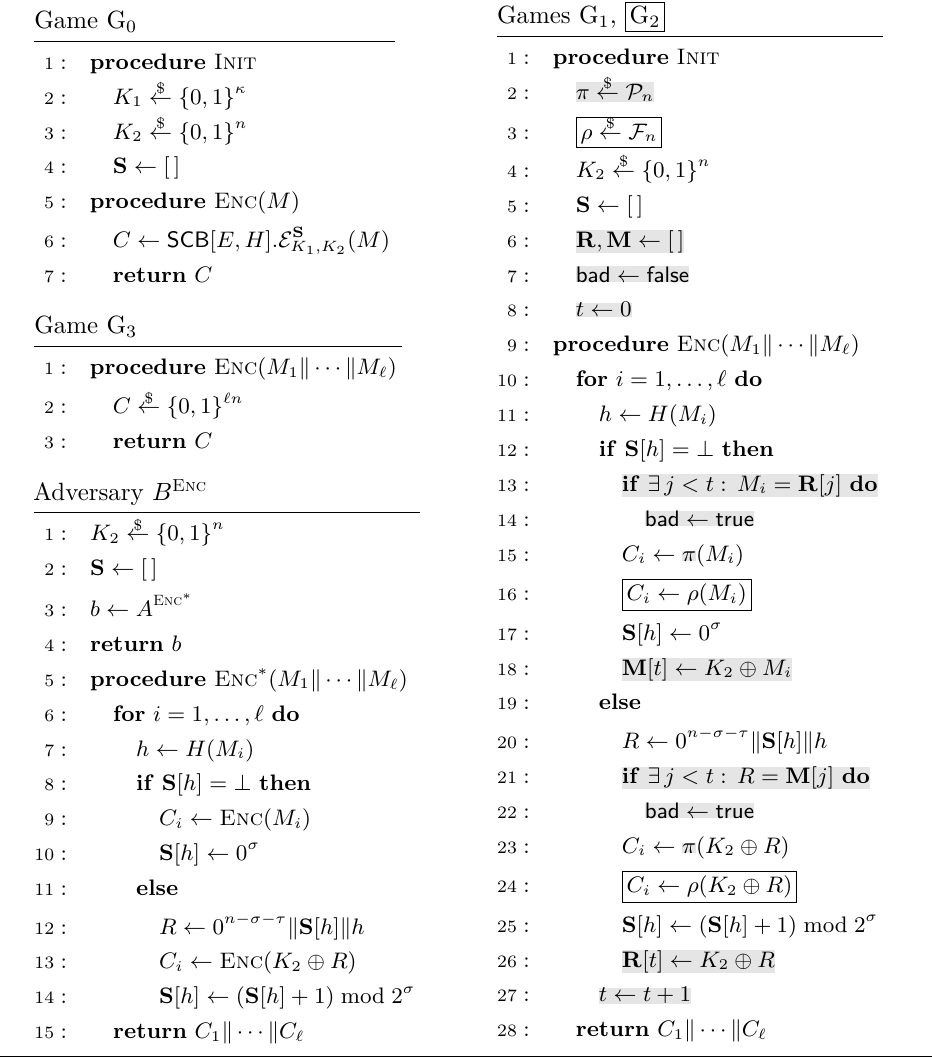
to game G are highlighted in the description of G 0 1 2